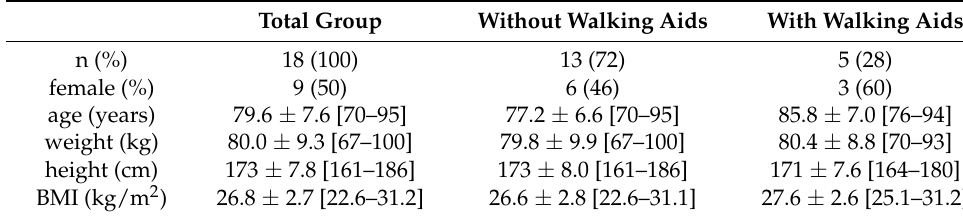
Table 1. General characteristics of the participants. Total Group